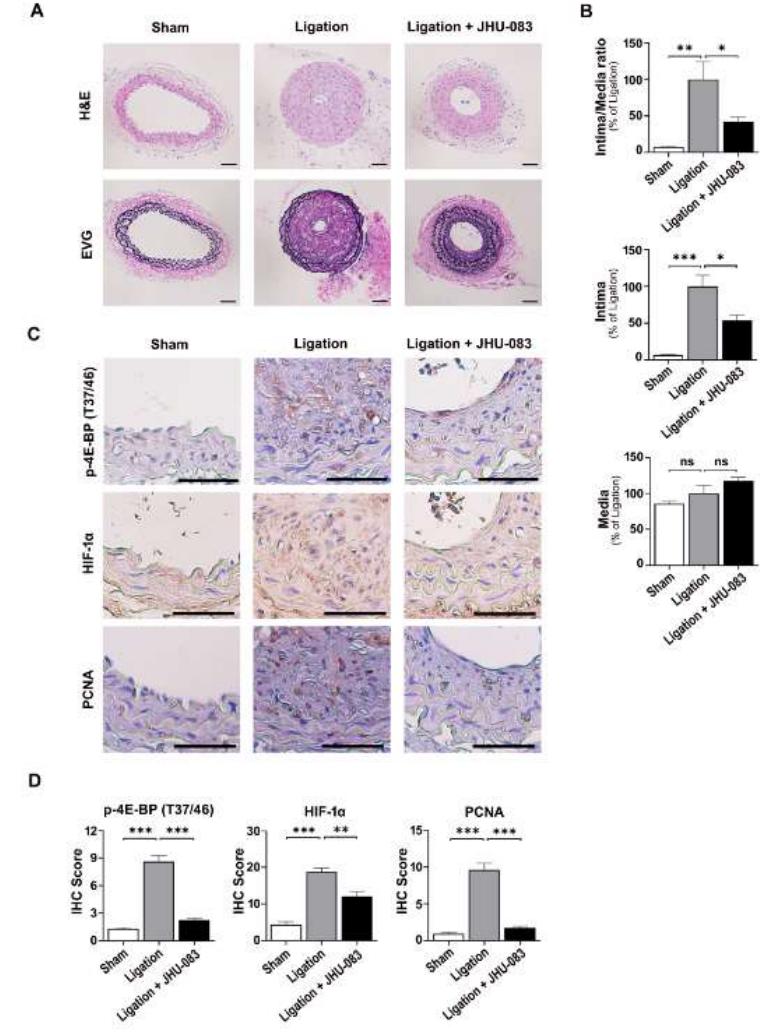
Figure 5. JHU-083 attenuates carotid artery ligation-induced neointimal hyperplasia. ( A ) Representative cross-sections of mouse carotid arteries stained with H&E and Elastic-van Gieson (EVG), Scale bar represents 50 µm. ( B ) The relative ratios of the neointimal and medial areas, the intimal area, and the medial area quantified by morphometric analysis. Data are expressed as the mean ± SEM ( n = 4 – 5 per group). ( C ) Immunohistochemical staining of PCNA, p-4E-BP(Thr37/46) and HIF- 1α in mouse carotid arteries. ( D ) Cells immunohistochemically positive for PCNA, p-4E- BP(Thr37/46), and HIF- 1α in arteries were quantified. Data are expressed as mean ± SEM ( n = 4 – 5 per group). Scale bar represents 50 µm. NS, not significant; * p < 0.05, ** p < 0.01, and *** p < 0.001.